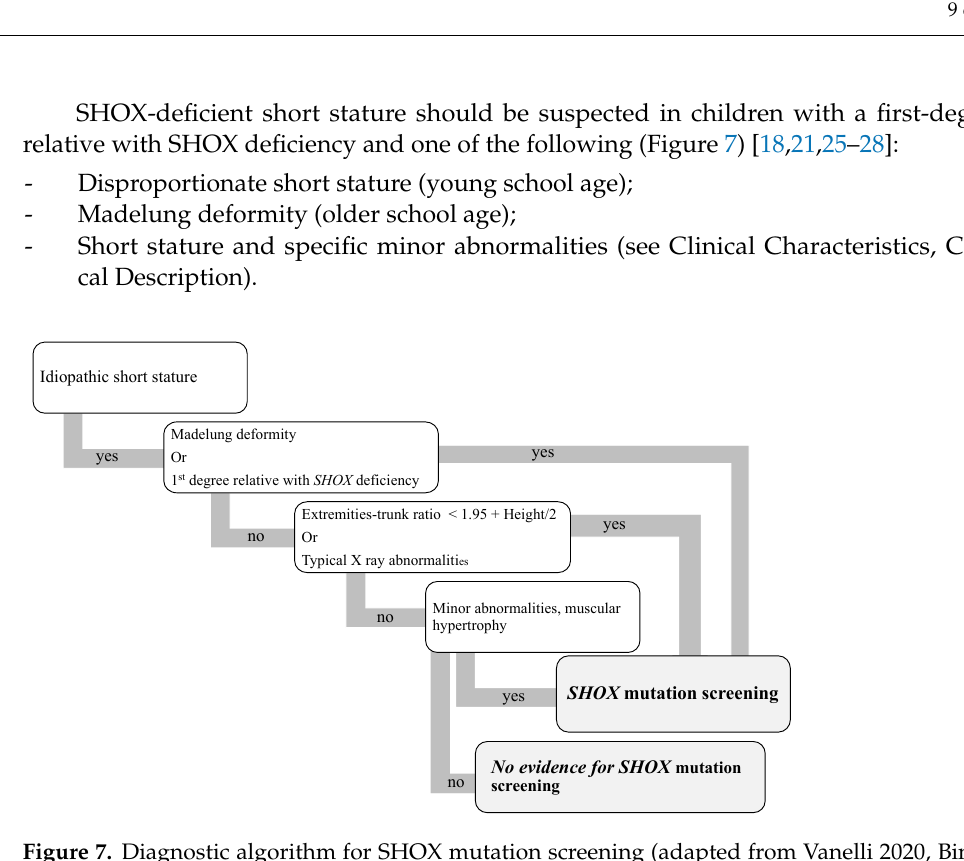
Figure 6. Radiological findings in SHOX deficiency (adapted from Vanelli et al. 2020).